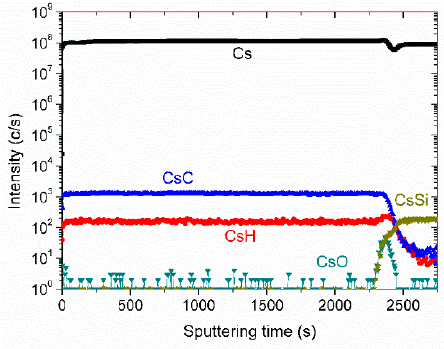
Figure 2. Secondary ion mass spectrometry depth profile of the sample prepared by a − 1 kV DC voltage superposed by a − 17 kV pulse, using the C 7 H 8 precursor. Shown are positive secondary ion signals.